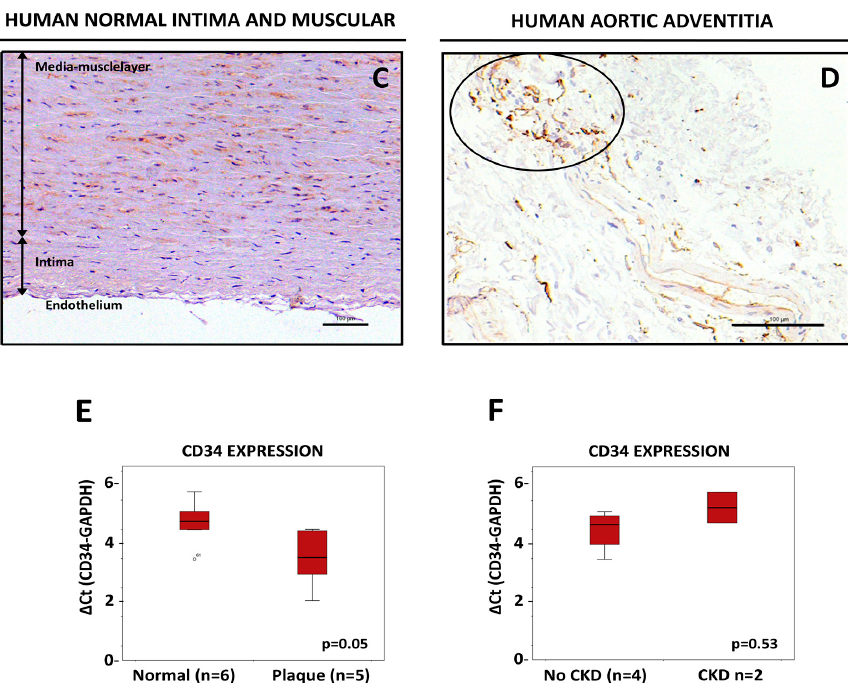
Figure 2. Detection of CD34-positive cells in human aortic tissue. Whole human arteries were isolated, sliced, prepared for IHQ analysis and stained for CD34 as described in Material and Methods. ( A , B ) Shown are representative images of two different neointimas, stained for anti-CD34, at different magnifications (20 × in 3A, 40 × in 3B). The circle in ( A ) shows a cluster of CD34-positive cells, and arrows in ( B ) show ±± individual fibroblastoid cells positive for CD34 staining. Tissues were counterstained with hematoxilin-eosin. Bars are 100 µ m. ( C ) Representative image of a human aortic tissue from a normal section (non-lesion) showing the intima and the muscular layer (vertical arrows) and stained for anti-CD34. Tissue was counterstained with hematoxilin-eosin. Bar is 100 µ m. ( D ) Representative image of a human adventitia stained for anti-CD34. The circle in ( D ) shows a cluster of CD34-positive cells. Tissue was counterstained with hematoxilin-eosin. Bar is 100 µ m. ( E ) Expression of CD34 mRNA measured by qPCR in human ATH plaques compared with normal abdominal aortas. ( F ) Expression of CD34 mRNA in aortic tissue with normal vascular walls from CKD patients when compared with non-CKD patients. We next dissected human ATH samples into plaque and normal tissue, which were tested by qPCR for mRNA levels of CD34 . Figure 2E show that CD34 mRNA levels in the plaque were significantly higher than in normal aortic tissue ( Δ Ct = 3.5 ± 1.03 cycles in plaque vs. 4.7 ± 0.76 cycles in normal tissue; p = 0.05). Since ATH is a frequent complication of Chronic Kidney Disease, we also tested CD34 mRNA expression in human normal aortas of CDK and non-CKD patients, but only a vs. 5.26 ± 0.75 cycles in CKD; p = 0.53, see Figure 2F).